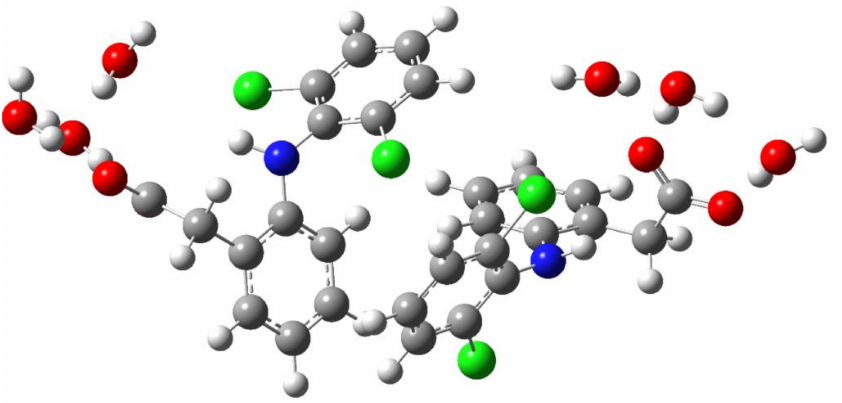
Figure 2. The structure of an associate of two hydrophobic ensembles (diclofenac anions with three water molecules). Red, blue, green, grey, and white circles represent oxygen, nitrogen, chlorine, carbon, and hydrogen atoms,